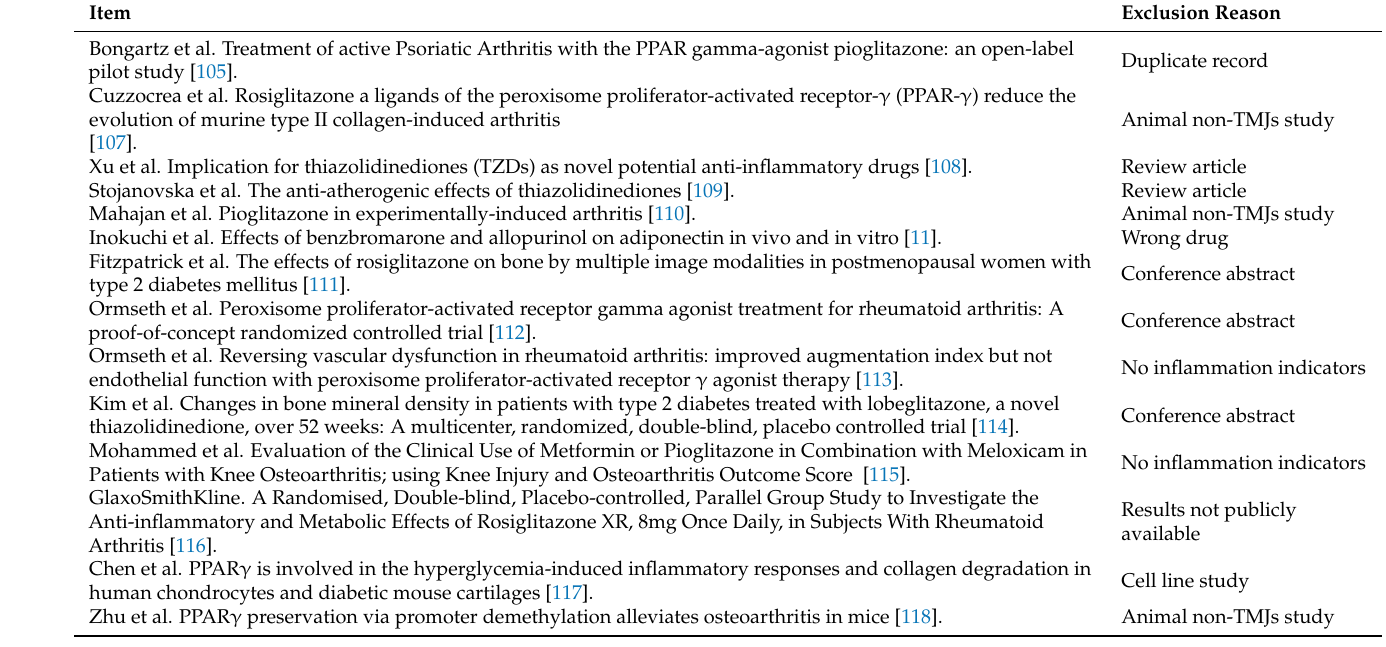
Table A3. Reasons for exclusion at the eligibility